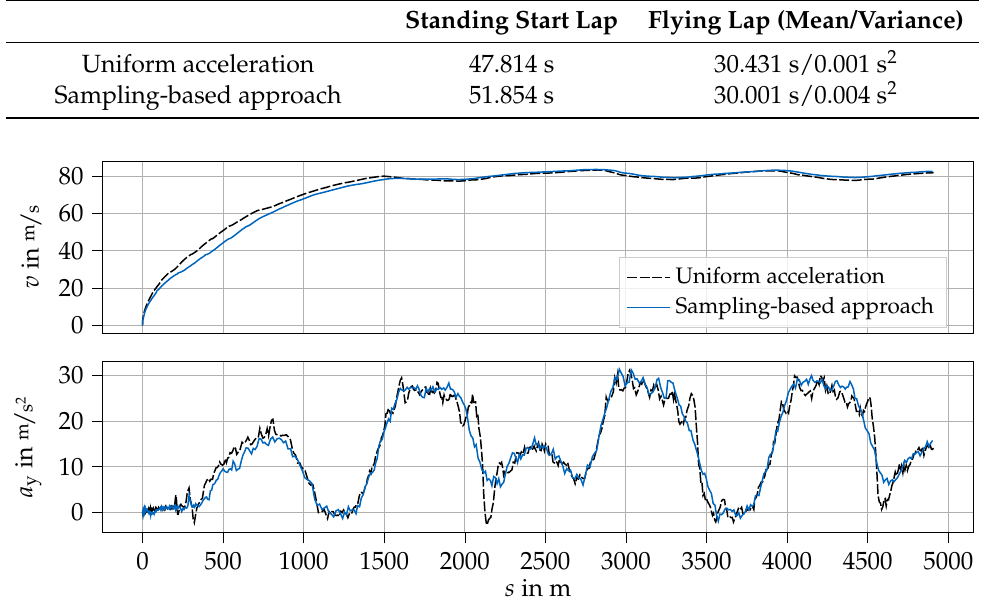
Figure 7. Comparison of our sampling-based approach and the uniform acceleration approach for a standing start and a flying lap on the